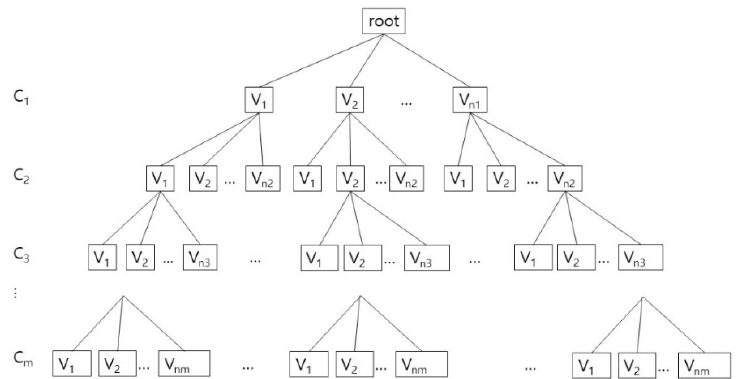
Figure 5. The combining process of the valid conformations V j , 0 < j ≤ n j , for the rotamer clique C i , 0 < i ≤ m.